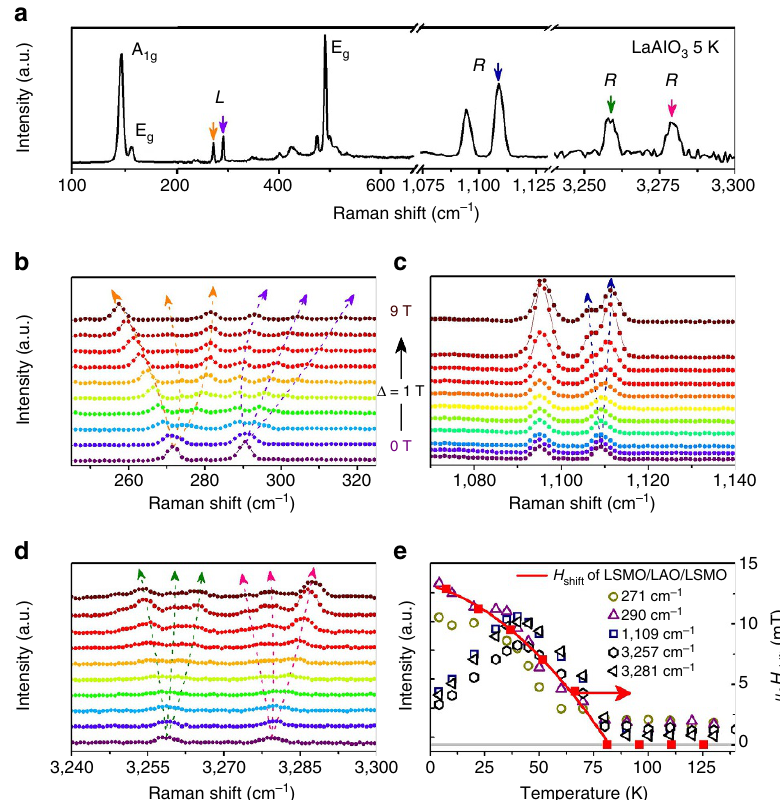
Figure 5 | Inelastic light scattering from an LaAlO 3 crystal at 5K under magnetic field. ( a ) The zero magnetic field spectrum of LaAlO 3 . ( b – d ) The field- dependent splitting of the spectral lines up to 9T. R denotes a Raman mode and L a luminescent transition. The transitions in d are third order of Raman lines in c . ( e ) The coincident temperature dependence of the magnetization oscillations including horizontal shift of the M–H loop ( H shift ) and the intensity of the magnetically split components in the luminescence/Raman